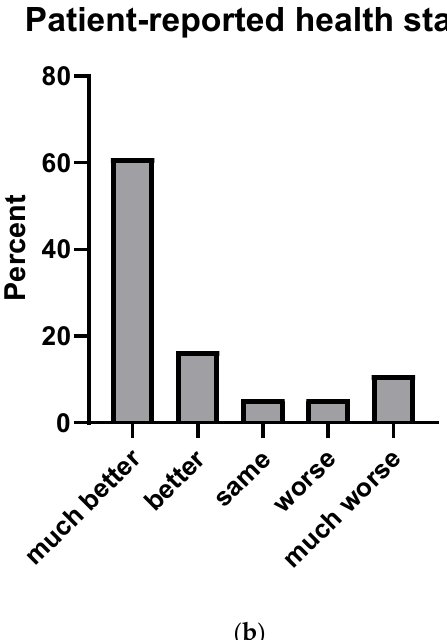
Table 4. Subscales of Short Form ‐ 36 Health Survey at long ‐ term follow ‐ up † .